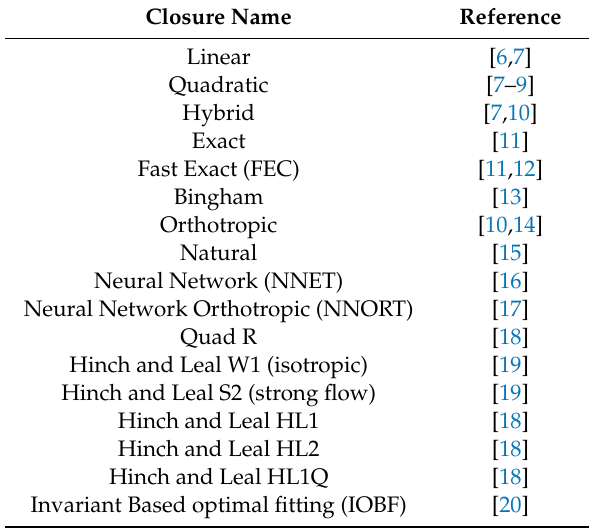
Table 2. List of closures for fourth-order fiber orientation tensor.